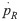
Schematic representation of the reproduction buffer handling rules for Odontaster validus.Arrows represent energy fluxes (J d-1). After paying for maturity costs p˙R is stored in the reproduction buffer E
R that is continuously being mobilized to develop the gonads. The gonads contain two different cohorts of oocytes, each one receiving energy at a rate given by p˙Yn, however cohort 1 is 365 days older than cohort 0 and p˙Yn depends on t (age). κ
R is the reproduction efficiency and represent the energy dissipated as the buffer is transformed into eggs.